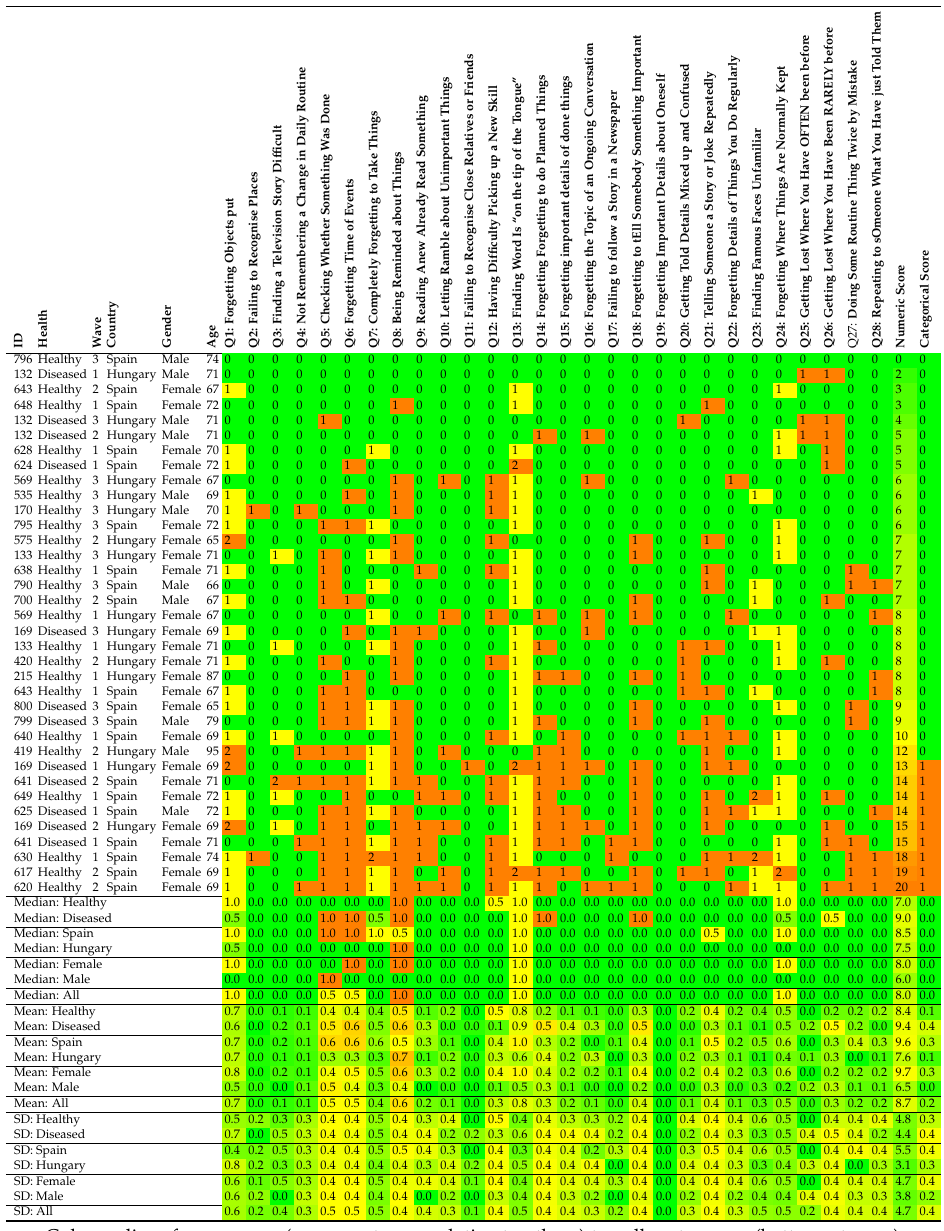
Table A8. Characteristics of PRO Memory